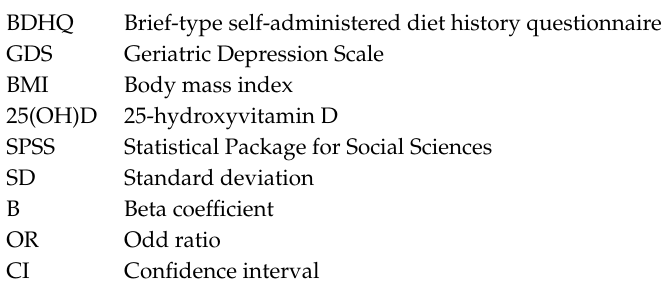
all participants. Table S4: Odds ratios (95% CI) for depressive symptom outcomes according to vitamin intake stratified by BMI in